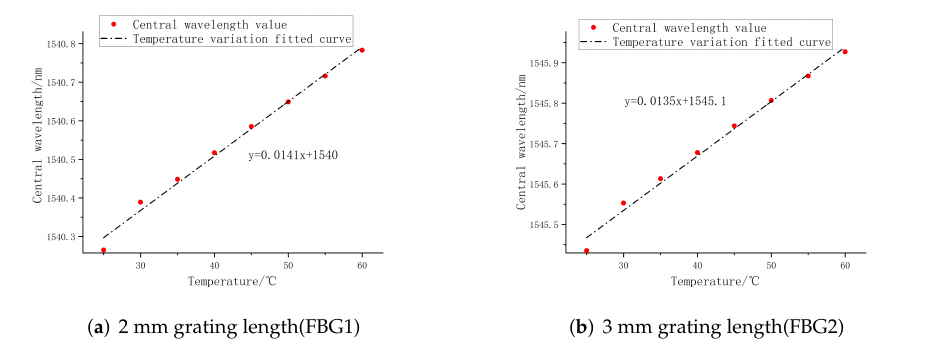
Figure 25. Temperature fitting curve of 25–60 ◦ C.